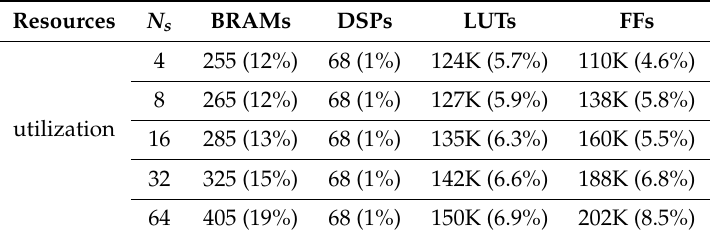
Table 2. Resource utilization.